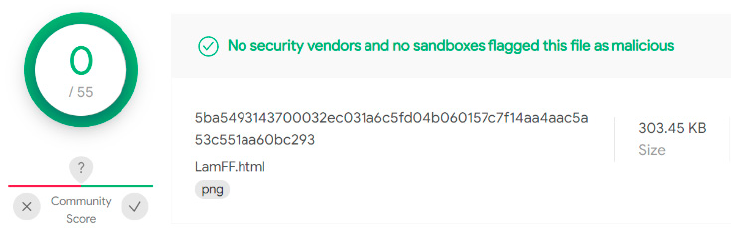
Figure 14. Malware detection in an image file.